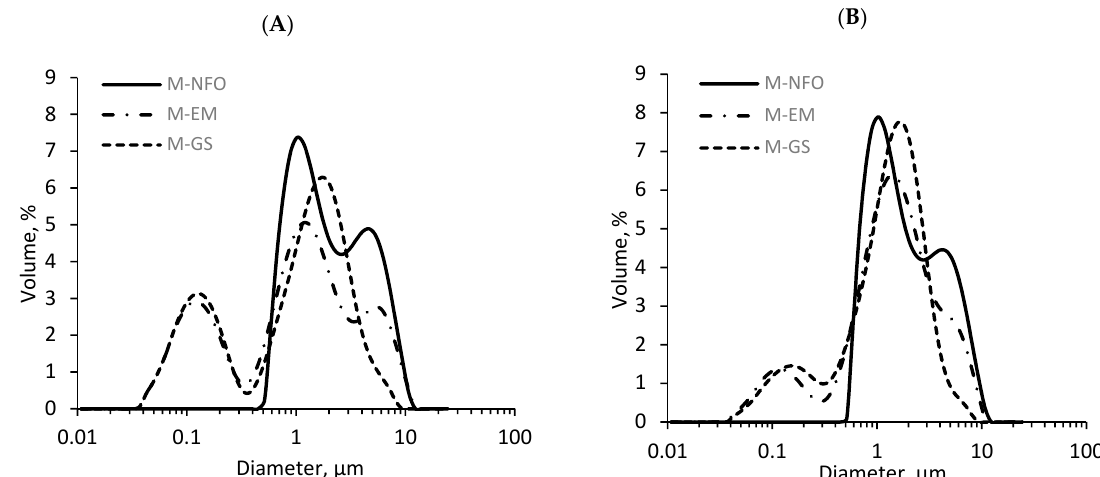
Figure 4. Droplet size distribution of low-fat mayonnaise enriched with: (i) neat fish oil (M-NFO), (ii) emulsified fish oil (M-EM) and (iii) microencapsulated fish oil (M-GS) at ( A ) day 0 and ( B ) day 28.